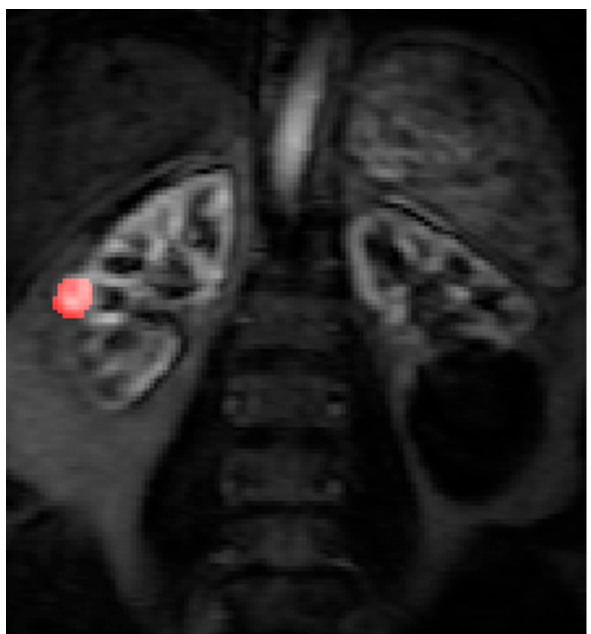
Figure 3. The right renal tumour is sited at the mid polar region of the kidney and there is a large renal cyst at the lower pole of the left kidney. The ROI is drawn on the maximum concentration map generated by Platform for Research in Medical Imaging (PMI) software before RFA treatment.